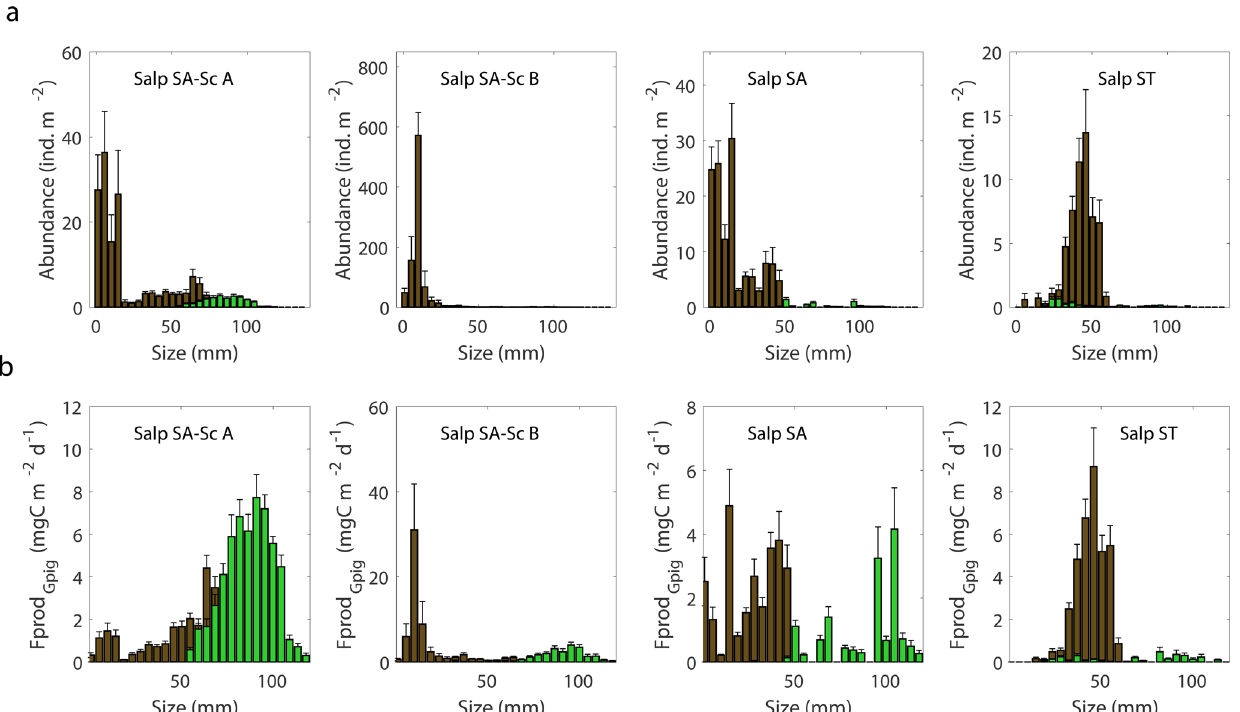
Fig. 4 | Size-speci fi c salp abundance and fecal pellet production rates. a Abundance (day/night averaged) of salps in the upper 200m, and b fecal pellet production (Fprod Gpig ) rates by size class for the four salp locations. Green bars